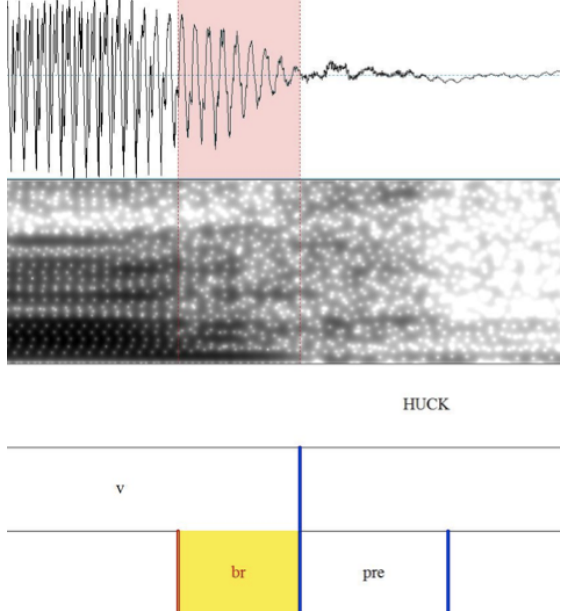
Figure 2: Identi(cid:976)ication of